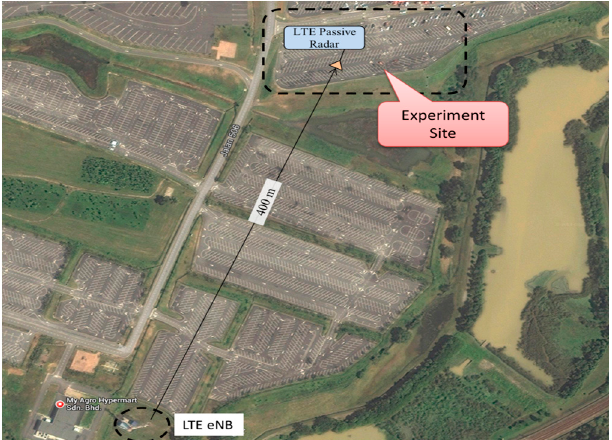
Figure 2. Aerial photo of geometrical experimental site showing LTE base station.